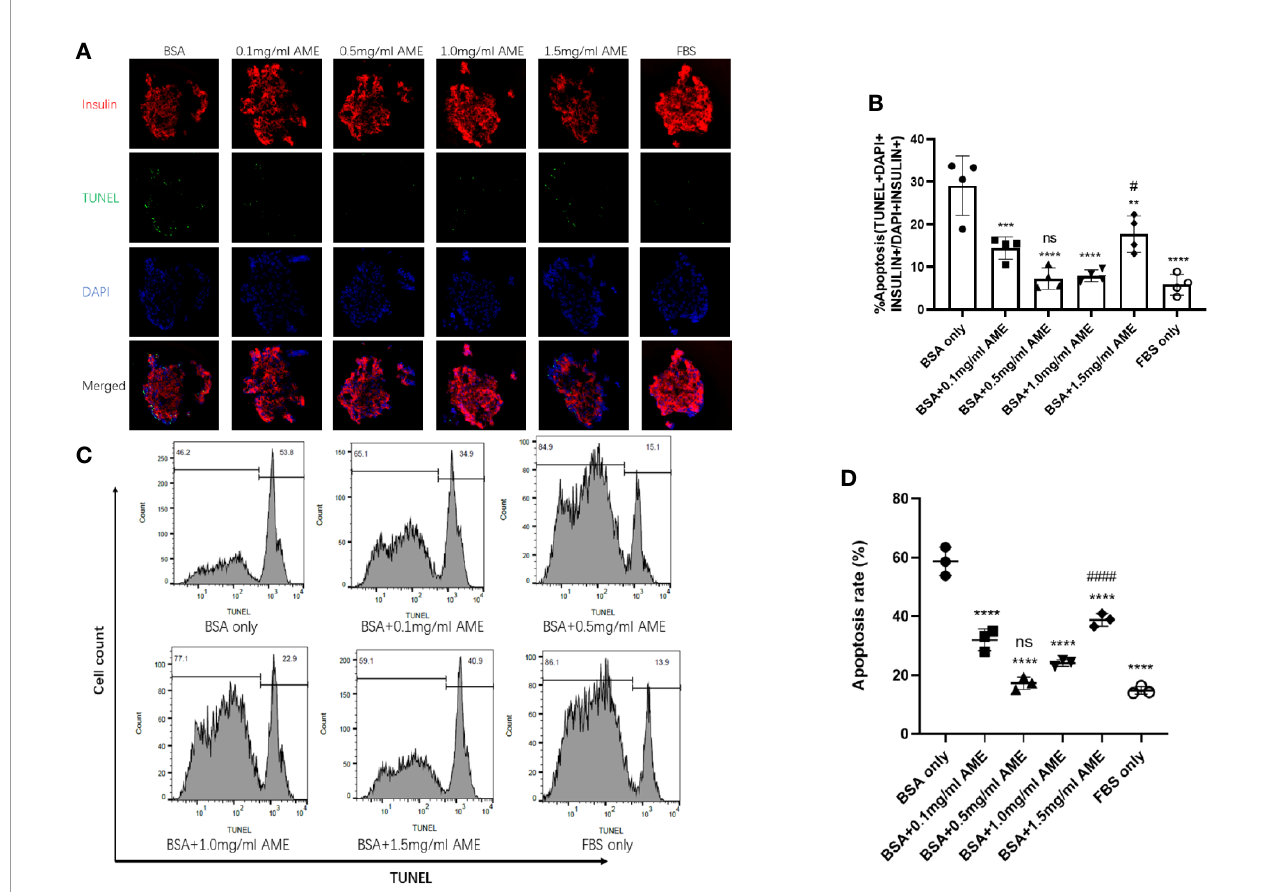
FIGURE 2 | AME signi fi cantly decreased the apoptosis rate of serum-deprived islets (A) . Representative images are showing TUNEL staining of isolated islets after 48 h cultivation. Insulin (red), apoptosis (green), and nucleus/DAPI (blue) were stained for the analysis (B) . The percentage of apoptosis was calculated as TUNEL +DAPI+Insulin+/DAPI+Insulin+. (**p < 0.01, ***p < 0.001, and ****p < 0.0001 vs. BSA only group. # p < 0.05 vs. BSA + 0.5 mg/ml AME, and ns vs. FBS only group, One-way ANOVA). Results are shown as means ± SD of four independent experiments, with 15 – 20 islets/condition for each independent experiment (C) . Detection of DNA fragmentation (TUNEL staining) by fl ow cytometry (D) . The percentage of apoptotic cells determined by fl ow cytometry following trypsin digestion. (****p < 0.0001 vs. BSA only group. #### p < 0.0001 vs. BSA + 0.5 mg/ml AME group, and ns vs. FBS only group, One-way ANOVA). Results are shown as means ± SD of three independent ( Figure 3 ). The current data supported the protective effect of AME on serum-deprived islets, which peaked at the concentration of 0.5 mg/ml; therefore, the concentration of 0.5 mg/ml was used for subsequent experiments.